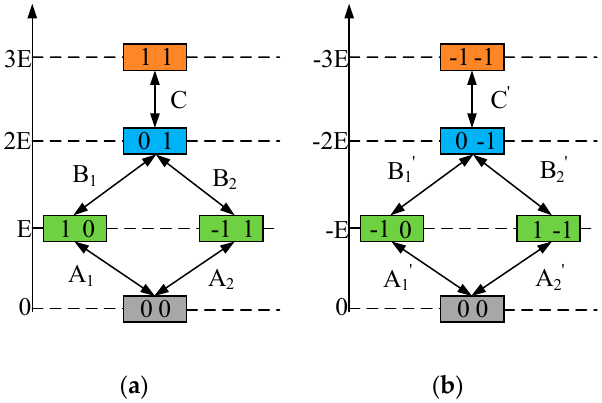
Figure 2. Synthesis of PWM level in di ff erent intervals. ( a ) Positive half period. ( b ) Negative half period.